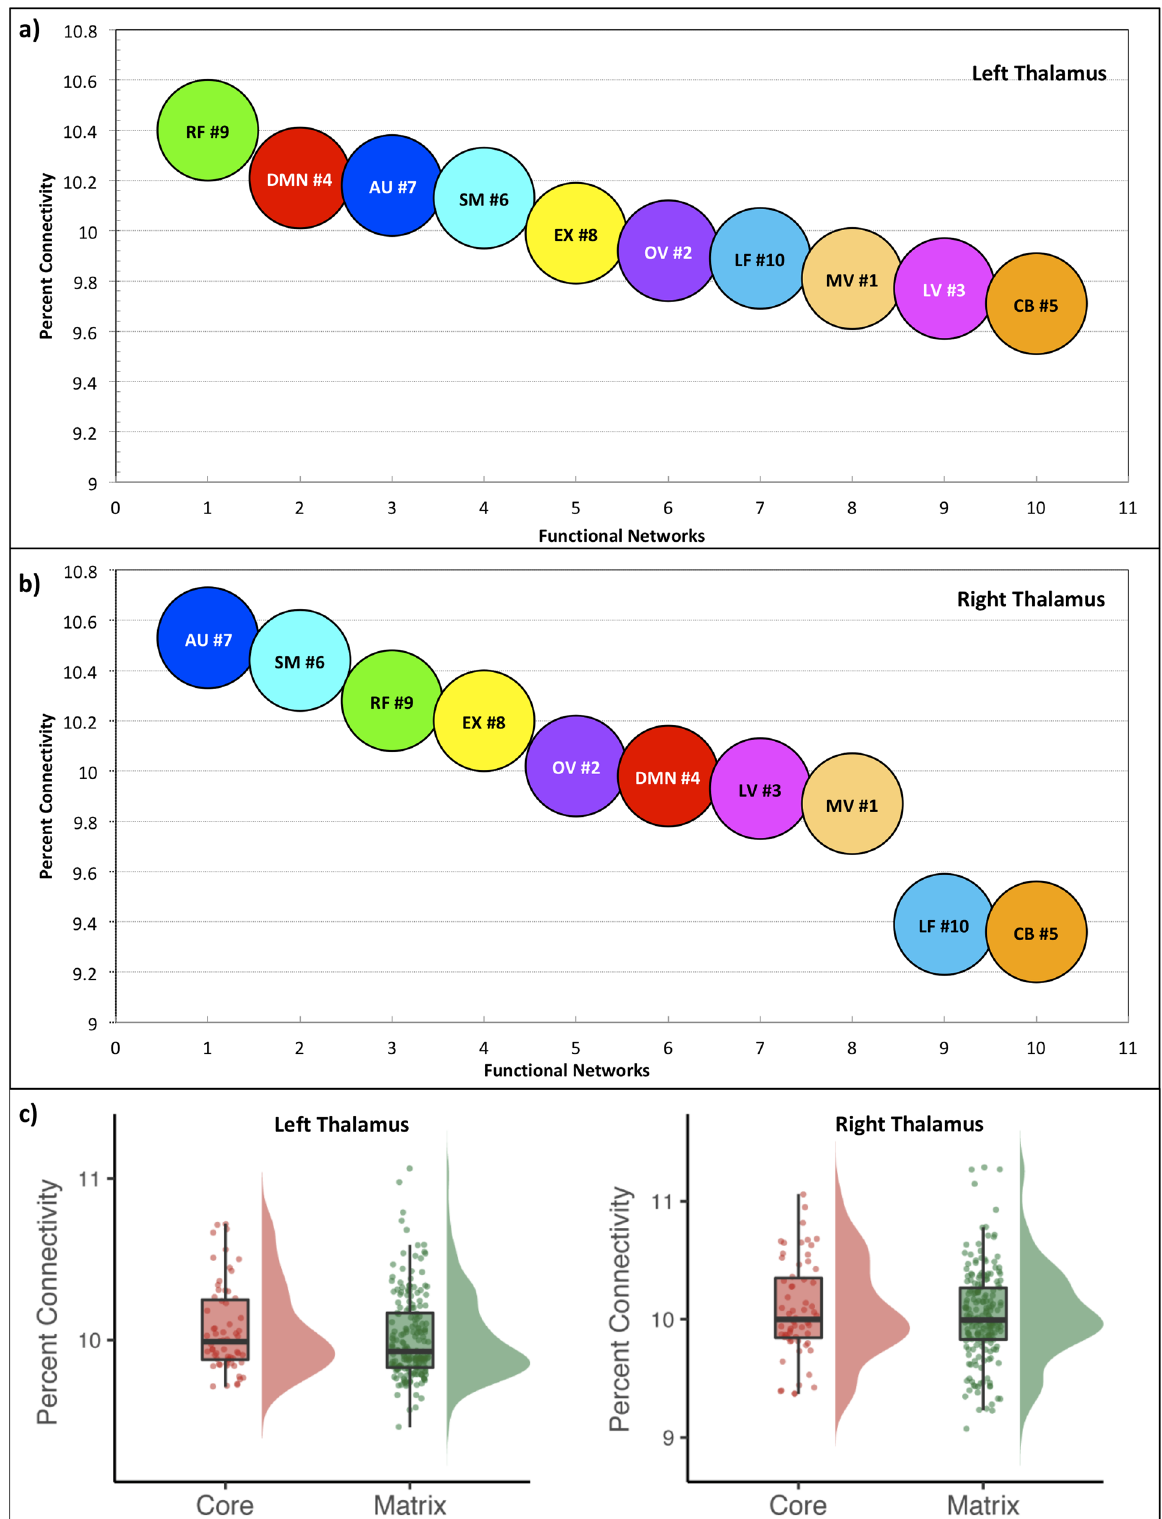
temporal, language-reading-word, prefrontal-cortex-pfc, and hemisphere-language-stroke. are the prefrontal-cortex-pfc, control-con fl ict-task,